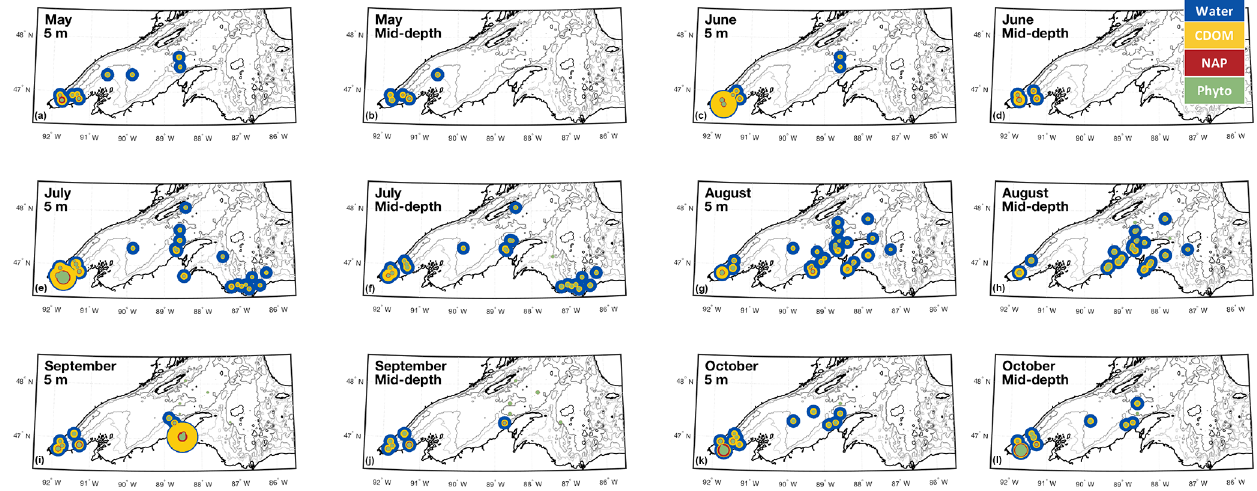
Figure 3. Absorption for discrete water samples taken at 5m and mid-depth throughout Lake Superior grouped by month. The outer diameter for each station marker is relative to total absorption with the contribution of water, CDOM, non-algal particles, and phytoplankton indicated by the relative size of the concentric circles.